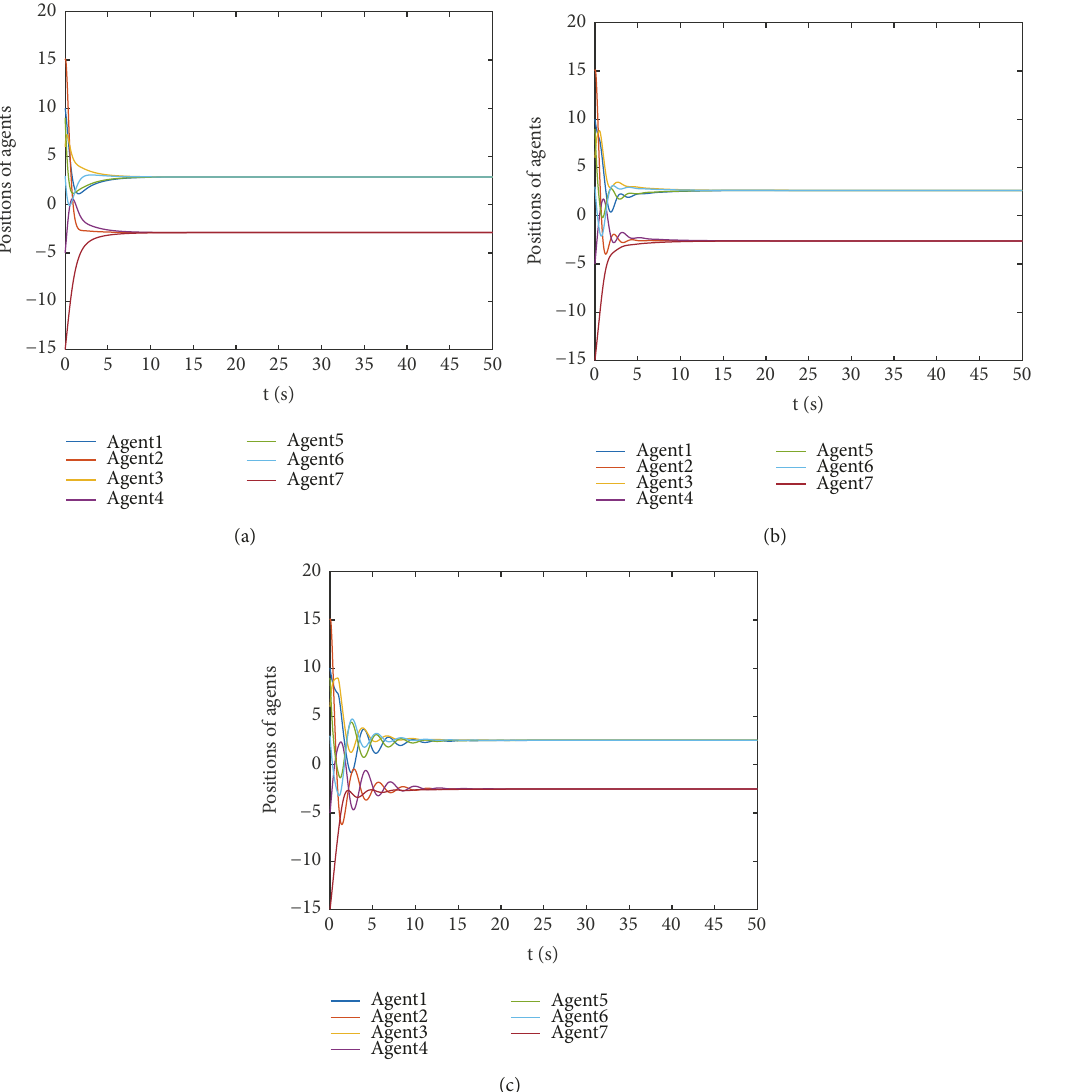
Figure 2: The agents position trajectories, where 𝜏 = 0.05 . (a) 𝜏 𝑖𝑗 = 0 , (b) 𝜏 𝑖𝑗 = 0.5 , and (c) 𝜏 𝑖𝑗 = 0.9